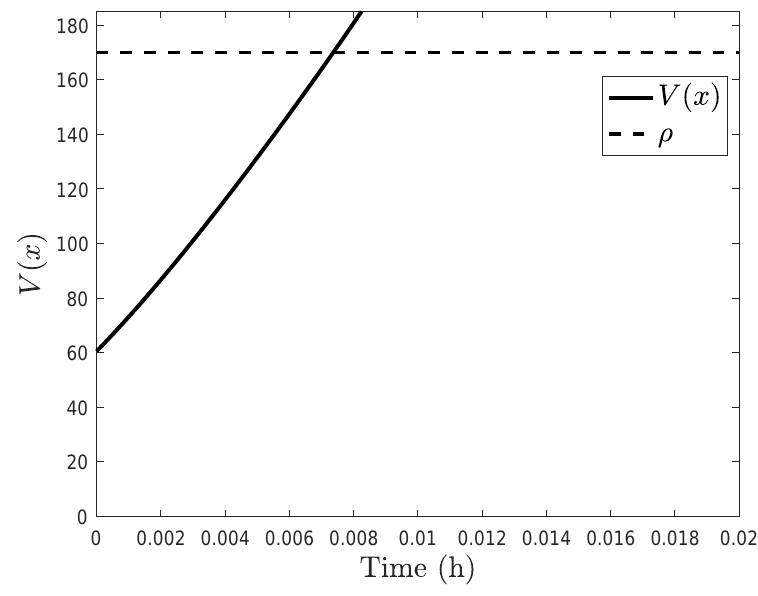
Figure 16. V ( x ) throughout the first sampling period with x 1 = 0.2 kmol/m 3 and x 2 = 5 K and ρ (cid:48) = 170.